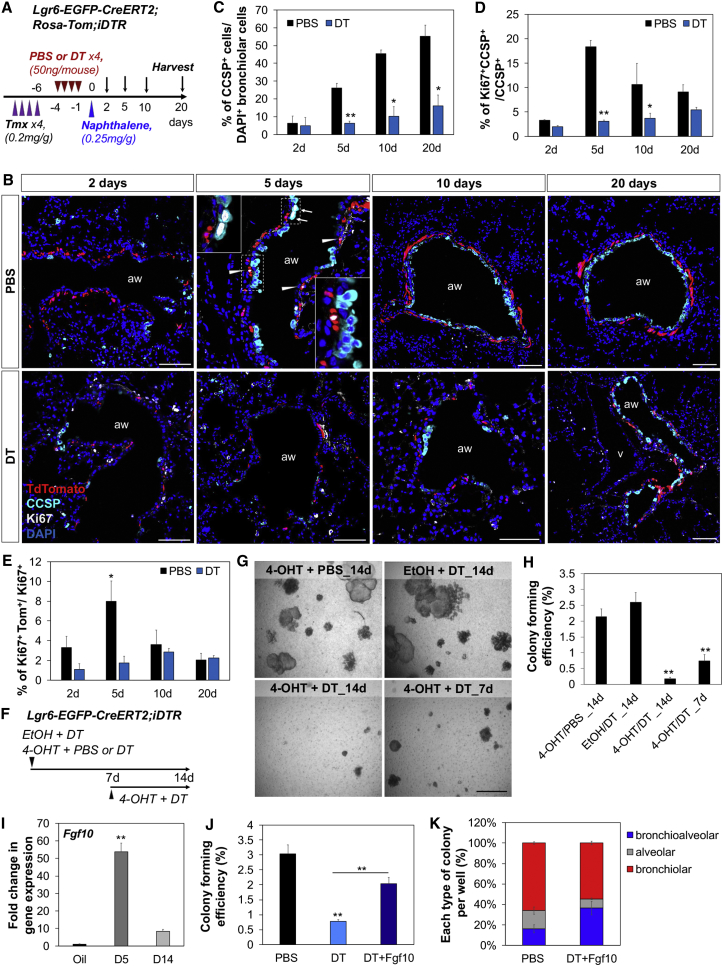
Impaired Airway Regeneration after Ablating Lgr6+ Cells(A) Schematics of the Lgr6-EGFP-CreERT2;R26-Tom lineage-tracing experiment after airway injury.(B) Representative confocal images showing extent of club cell injury or repair with (PBS, top) or without Lgr6+ cells (DT, bottom) after naphthalene administration by IF analysis: Tdtomato (for Lgr6, red); Ki67 (white); CCSP (cyan); and DAPI (blue). Arrow, Ki67+ airway epithelial cells; arrowhead, Ki67+Lgr6+ cells.(C–E) Quantification of naphthalene injury repair and expansion of Lgr6+ cells in lungs with or without Lgr6+ cells. (C) For club cell analysis, the percentage of DAPI-positive bronchiolar cells also positive for CCSP is assessed at indicated time points. (D and E) The mean percentage of club cells or lineage-labeled Lgr6+ cells that co-express Ki67 is assessed at indicated time points.(F) Experimental scheme of depleting Lgr6-expressing cells in co-culture of Scgb1a1+ cells.(G and H) Representative phase-contrast images (G) and colony forming efficiency (H) of primary lung organoids in (F).(I) qPCR analysis for the expression of Fgf10 in isolated lineage-labeled Lgr6+ cells from naphthalene-treated lungs. Shown is normalized to Gapdh.(J and K) Colony forming efficiency (J) and quantification of each distinct colony type (K) of lung organoids with addition of DT and Fgf10 at day 7 in cultures. Data presented are the mean of experiments from three individual mice per group (D, E, and I) or the mean of three independent experiments with triplicate wells (H, J, and K).Error bars indicate SD (∗p < 0.01; ∗∗p < 0.005). The scale bars represent 50 μm (B) and 500 μm (G). See also Figure S5.